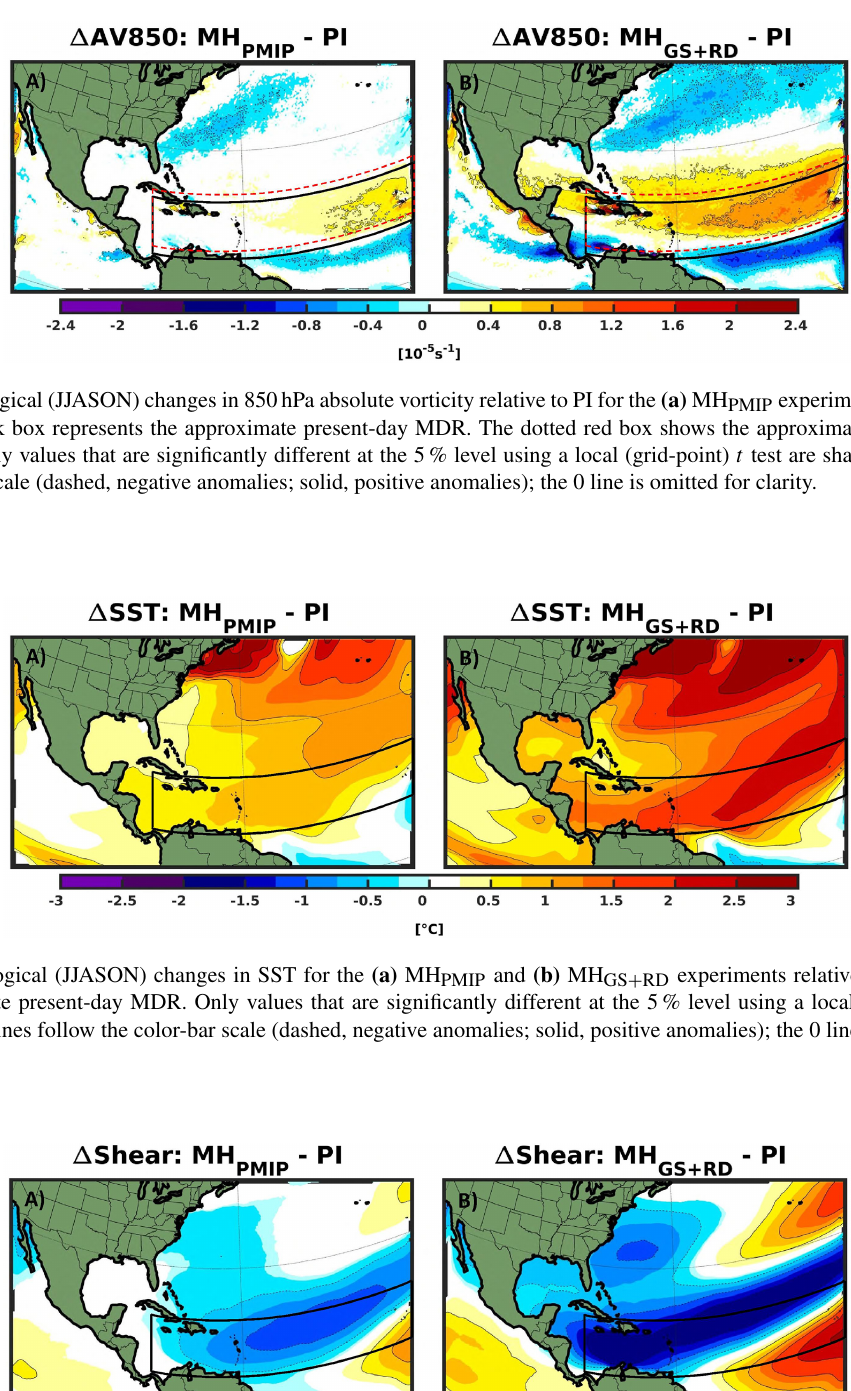
Clim. Past, 17, 675–701, 2021